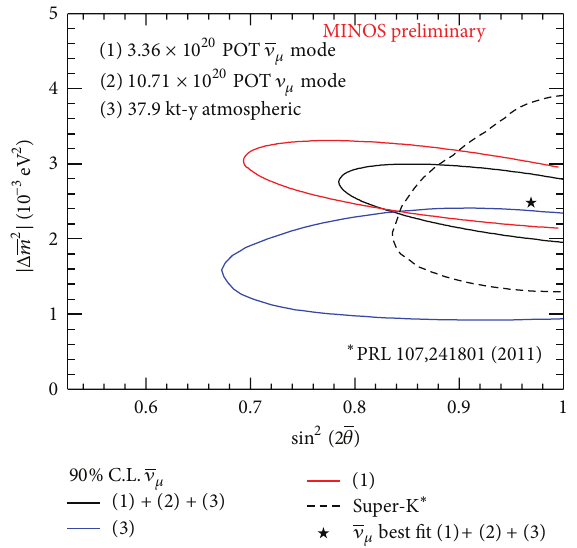
Figure 16: The 90% confidence regions for antineutrino parameters |Δ𝑚 2 | and sin 2 (2𝜃) . Antineutrino results are shown from Super- atm Kamiokande [51] (dashed black) alongside the latest preliminary results from MINOS [45] (solid black). The MINOS results used three data sets: (1) atmospheric antineutrinos; (2) antineutrinos fromtheNuMIbeamoperatinginantineutrino-enhancedmode;(3) antineutrinos from the neutrino-enhanced beam. The red contour shows the result from just the NuMI beam data and the blue contour from just the atmospheric antineutrino